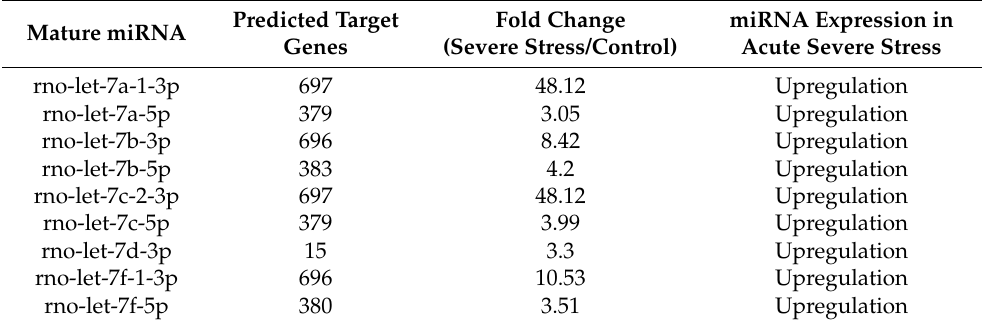
Table 1. Up/downregulation of miRNAs induced by acute severe